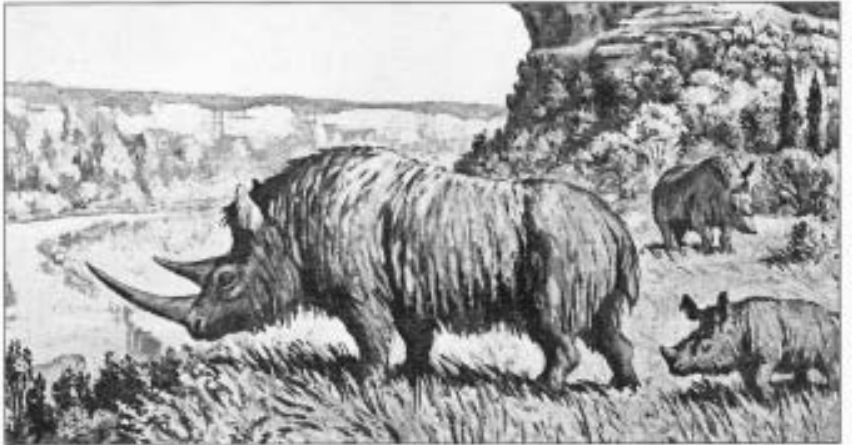
Figure 4 Diorama of woolly rhinoceroses on a ledge above the Vezere River in the Dordogne region of France during the most recent glaciation; painted in sepia and white by Marjorie Maitland Howard (reproduced from plate 25b in the 4th edition of Dating the past,